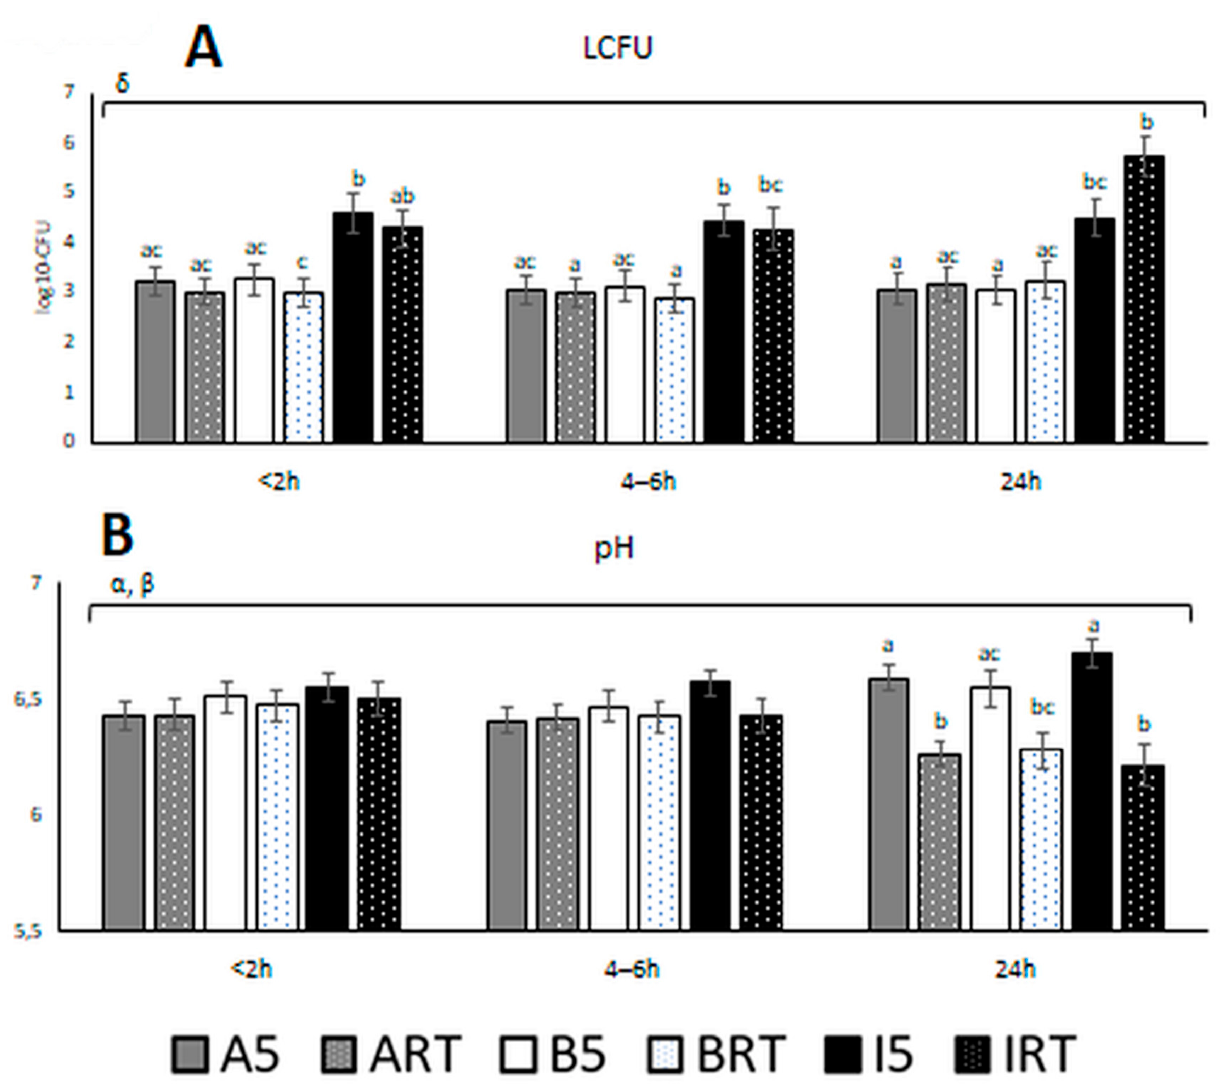
Figure 5. ( A ) Microbiological quality (log10-CFU) and ( B ) pH of bull semen at three different assessment time windows after semen collection, using three different semen extenders and two holding temperatures. Aliquots abbreviations: A: AndroMed ® ; B: BIOXcell ® ; I: INRA96 ® ; RT: room temperature; 5: refrigeration at 5 ◦ C. Factors abbreviations: t: time; Temp: temperature; Ex: extender; α : interaction temperature by extender; β : interaction temperature by time; γ : interaction extender by time; δ : interaction temperature by extender by time. Bars with different letters denote significantly different values ( p < 0.05) among the six aliquots of the three extenders by two holding temperatures at each fixed time window (ANOVA). Bars without letters were not significantly different. Square bracket over the bars highlights significant effect ( p < 0.05; from GLM analyses) of the factor or factors interactions during the time referred to with Greek letters. The bracket covers the time window where the effect is significant (from <2 to 4–6 h, from 4–6 to 24 h, or <2 to 24 h).